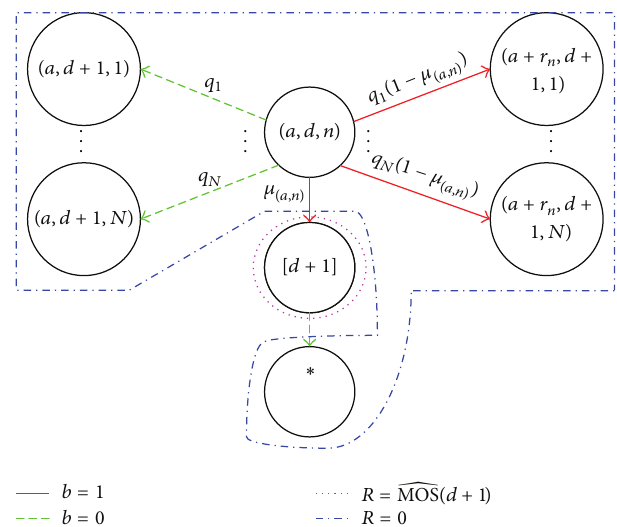
Figure 2: A part of per-user state